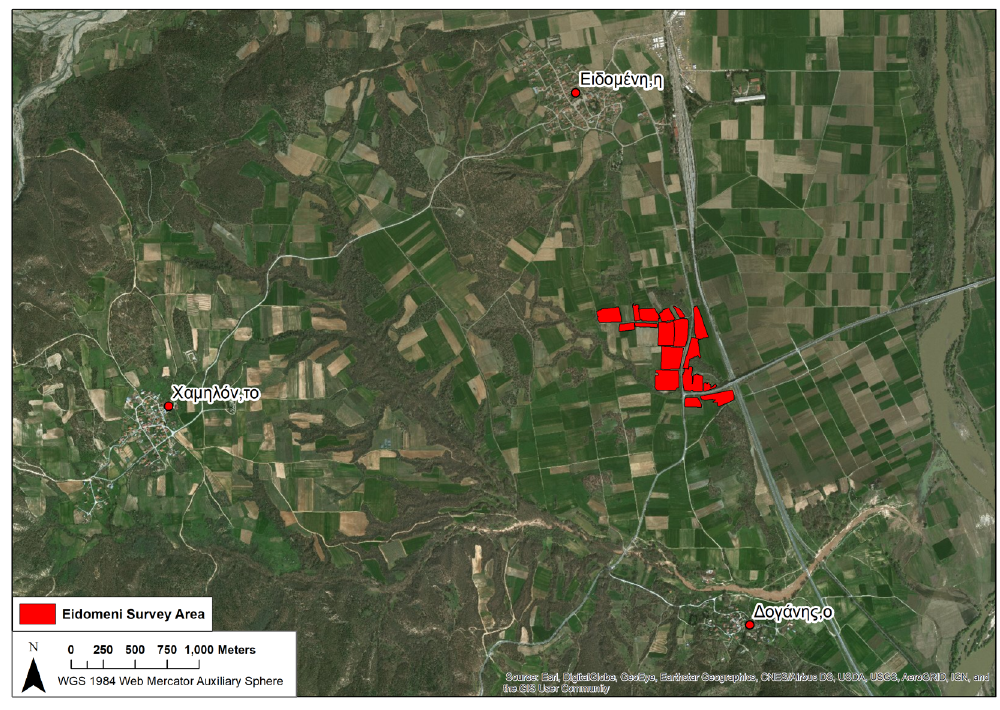
Figure 4 . The archaeological site and the geophysical survey area near Idomeni (WGS 1984, WebMercator Auxiliary Sphere).